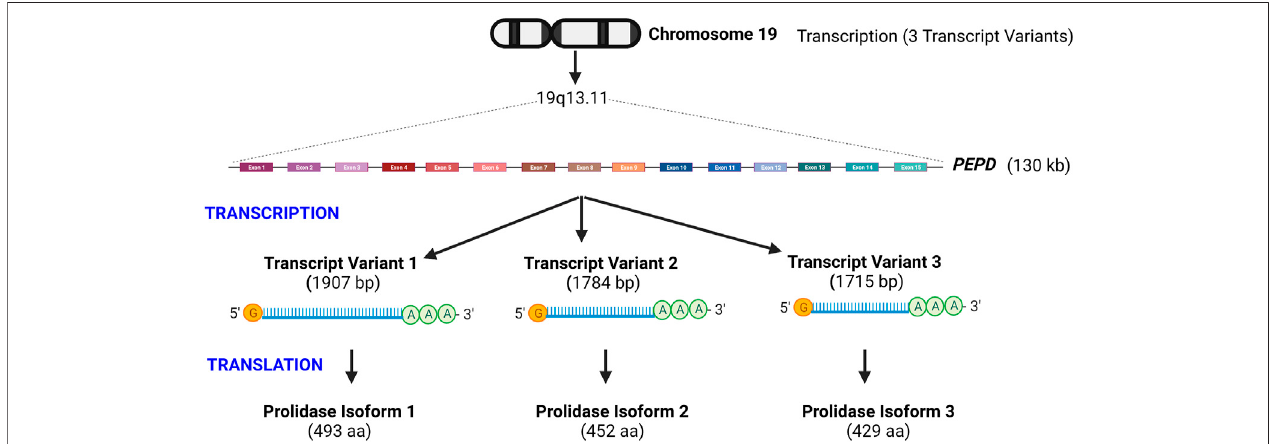
FIGURE 2 | Schematic illustration of prolidase gene organization- Prolidase encoded by the PEPD gene is located on chromosome 19q13.11. PEPD gene is 130 kb long and encodes three transcript variants that yield three protein isoforms. Isoform 1 is the longest and predominantly studied. Transcript variants 2 and 3 lack two alternate in-frame exons in the central coding region and are translated into proteins of shorter